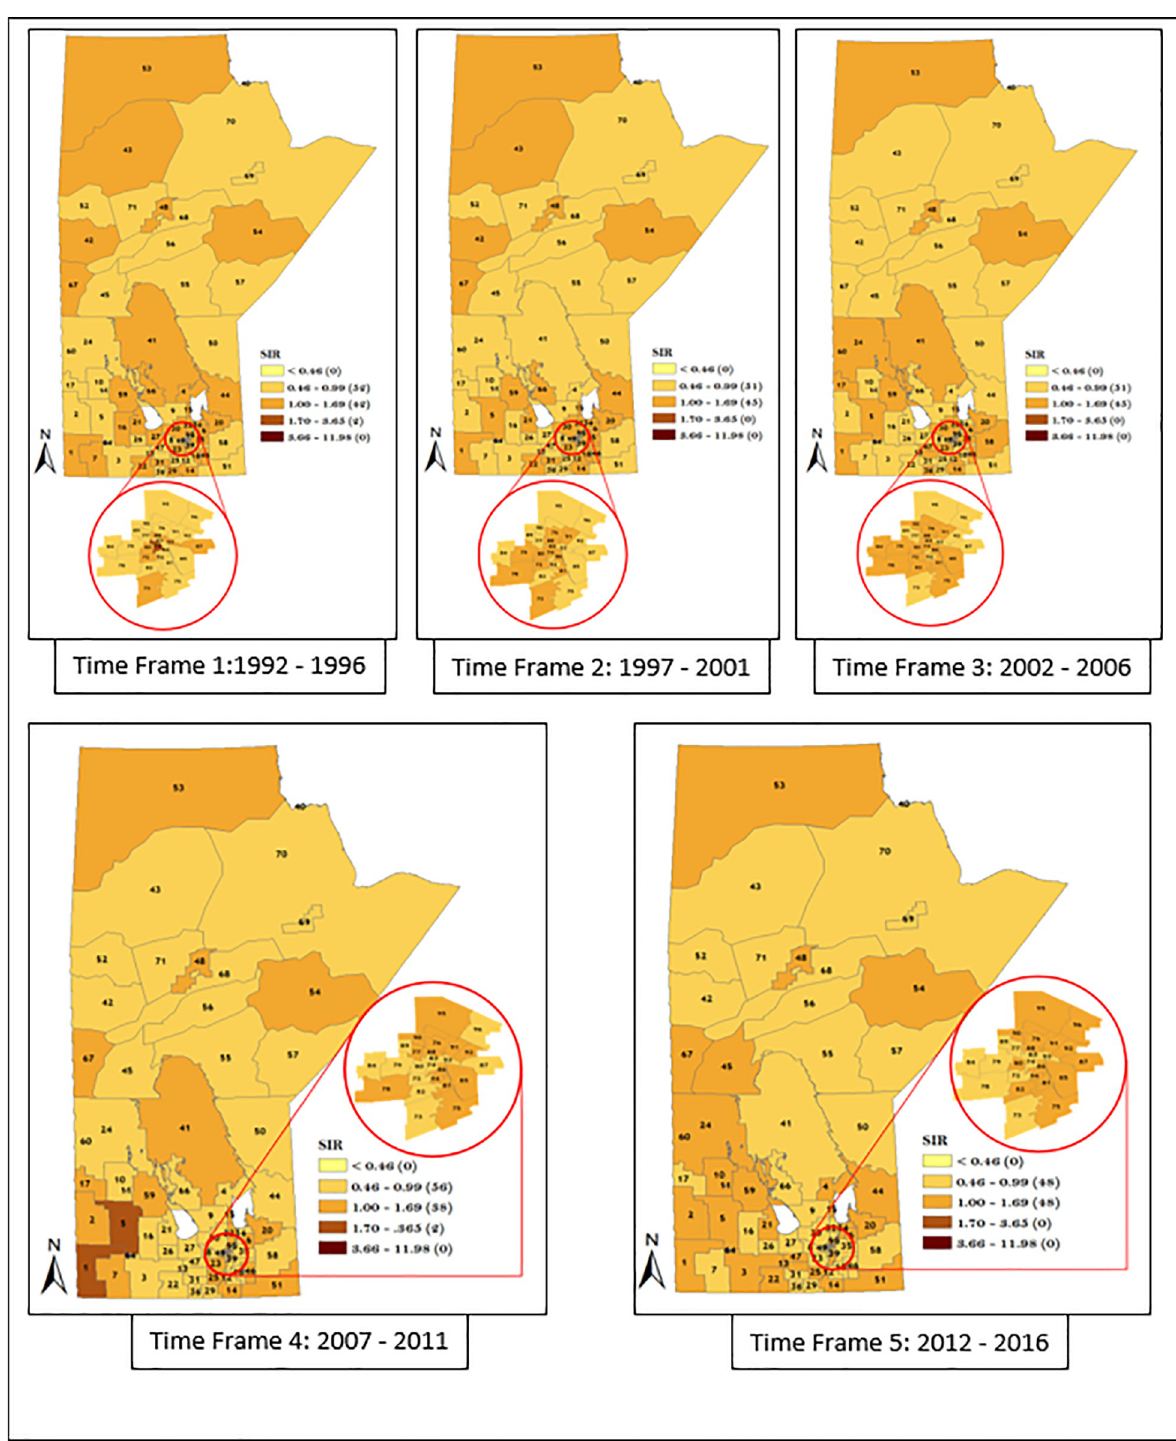
Fig 13. Maps of district-specific risk of CGC for 96 RHADs in Manitoba for five time periods using spatio-temporal Poisson regression model. Numbers in the map are the district labels from 1 to 96. Number of districts in each risk category is shown in parenthesis in the legends.